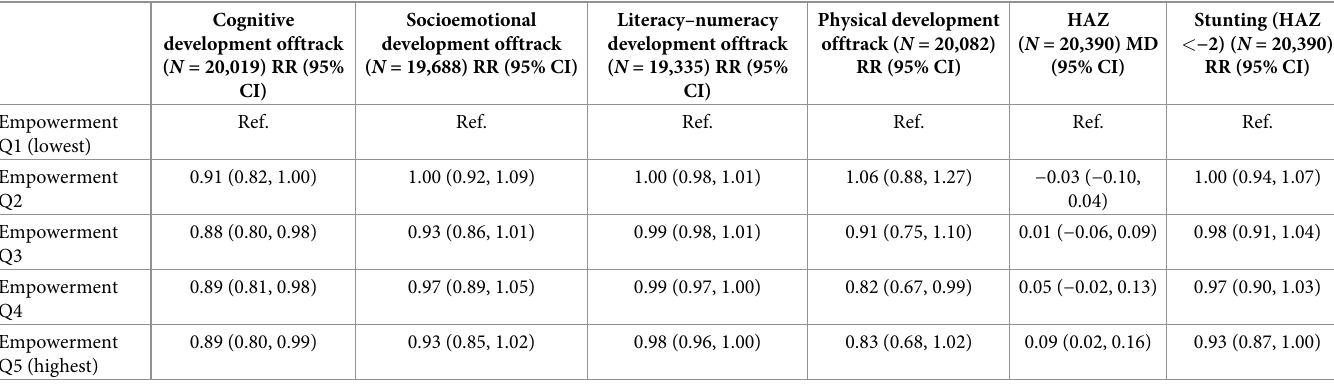
Table 3. Associations between quintile categories of women’s total empowerment and child development and growth outcomes a . Cognitive development